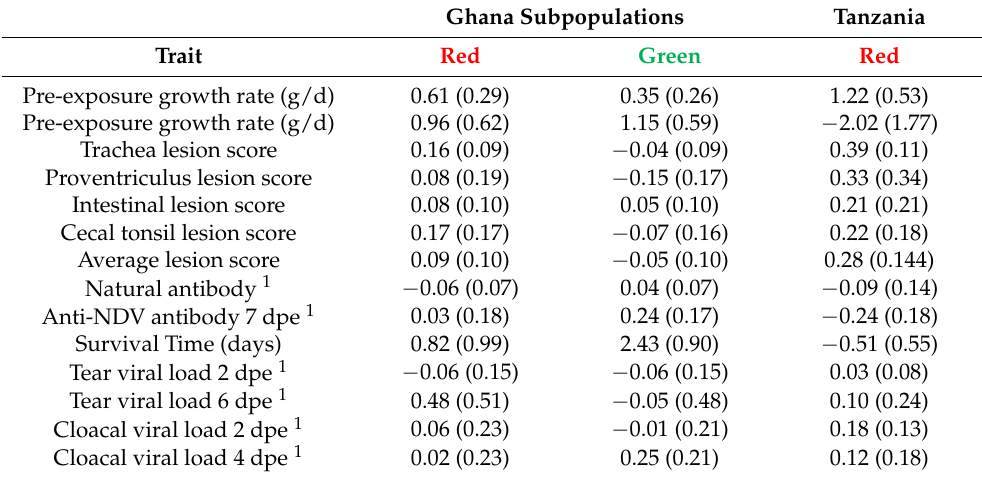
Figure 4. Admixture plot showing mixed ancestry among birds from the three Tanzanian ecotypes ( A ) (Ching’wekwe, Morogoro Medium, and Kuchi) and Ghanian ecotypes ( B ) (Coastal Savannah, Forest, and Interior Savannah). Table 1. Estimates of the effect of subpopulation proportions